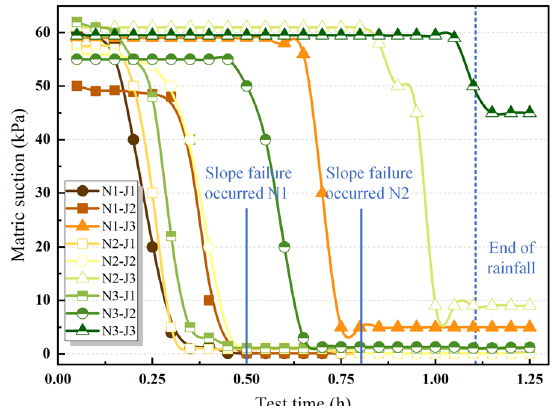
Fig. 14 Time history chart of matric suction change under different rainfall